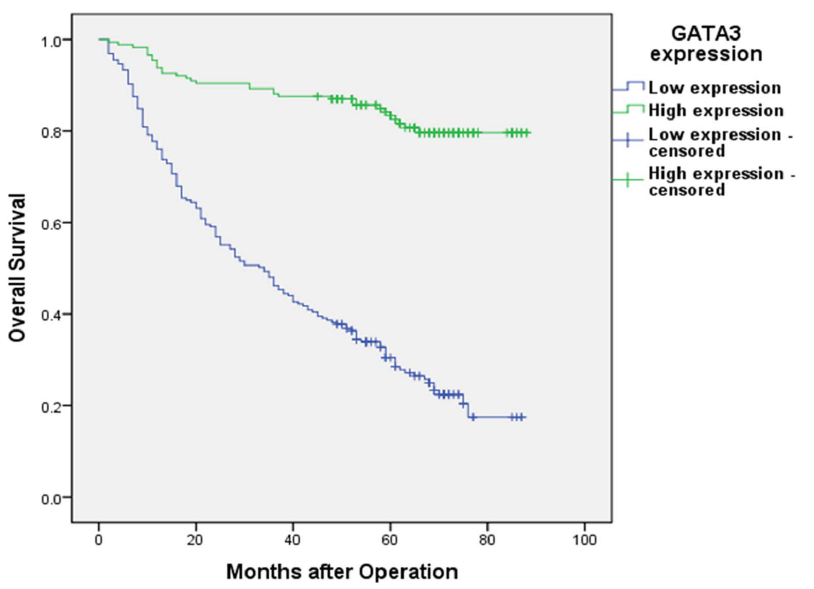
Figure 3. Kaplan-Meier survival curves of gastric cancer patients (n=402) after gastrectomy. The survival rate of the patients in the GATA3-low group (n=225) was significantly lower than that of the patients in the GATA3-high group (n=177) (log-rank test, P , 0.001).